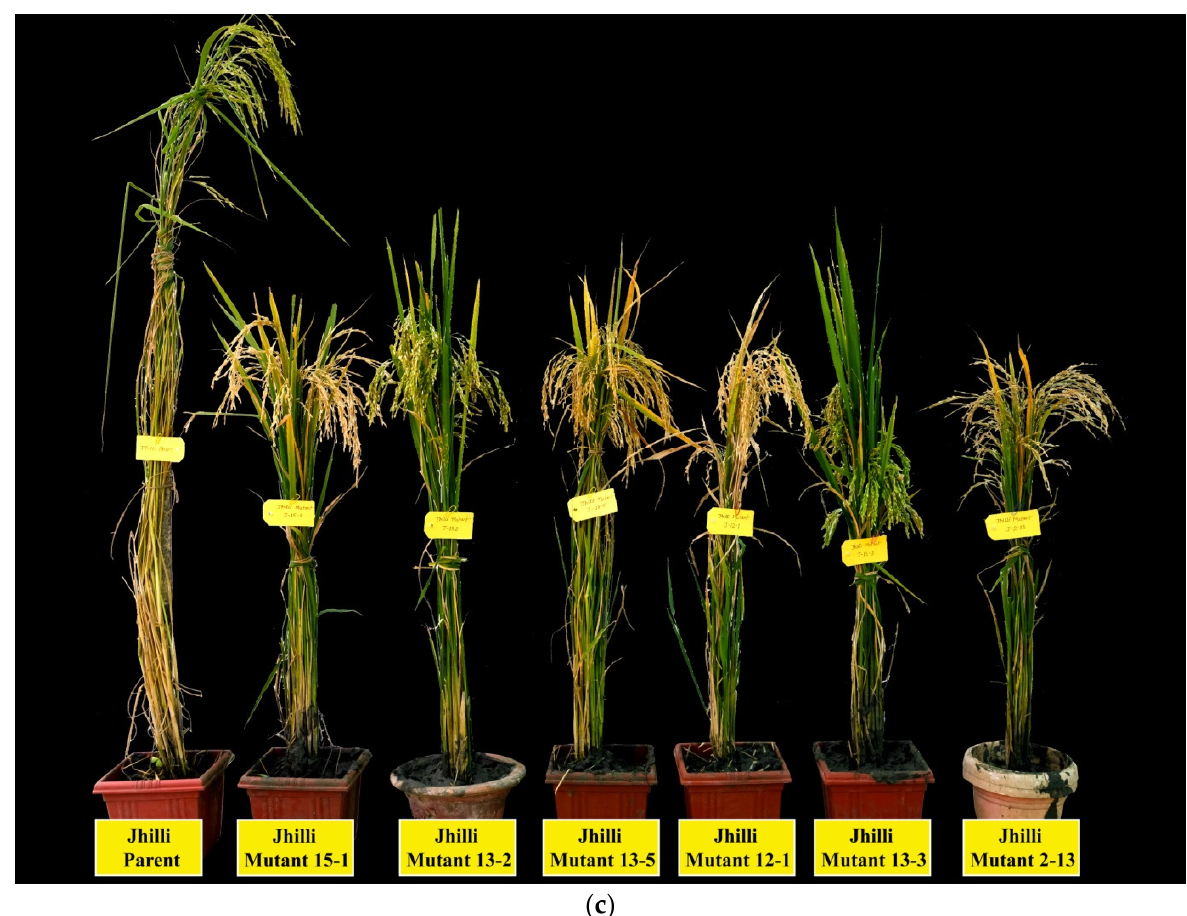
Figure 4. Comparative view of ( a ) Samundchini mutants, ( b ) Vishnubhog mutants and ( c ) Jhilli mutants with their corresponding parent.